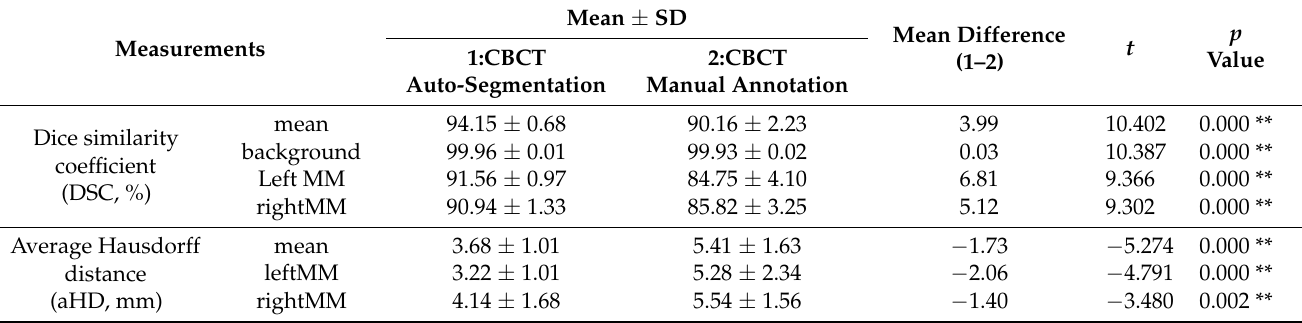
Table 3. Paired t -test for evaluation difference between auto-segmentations and manual annotations on